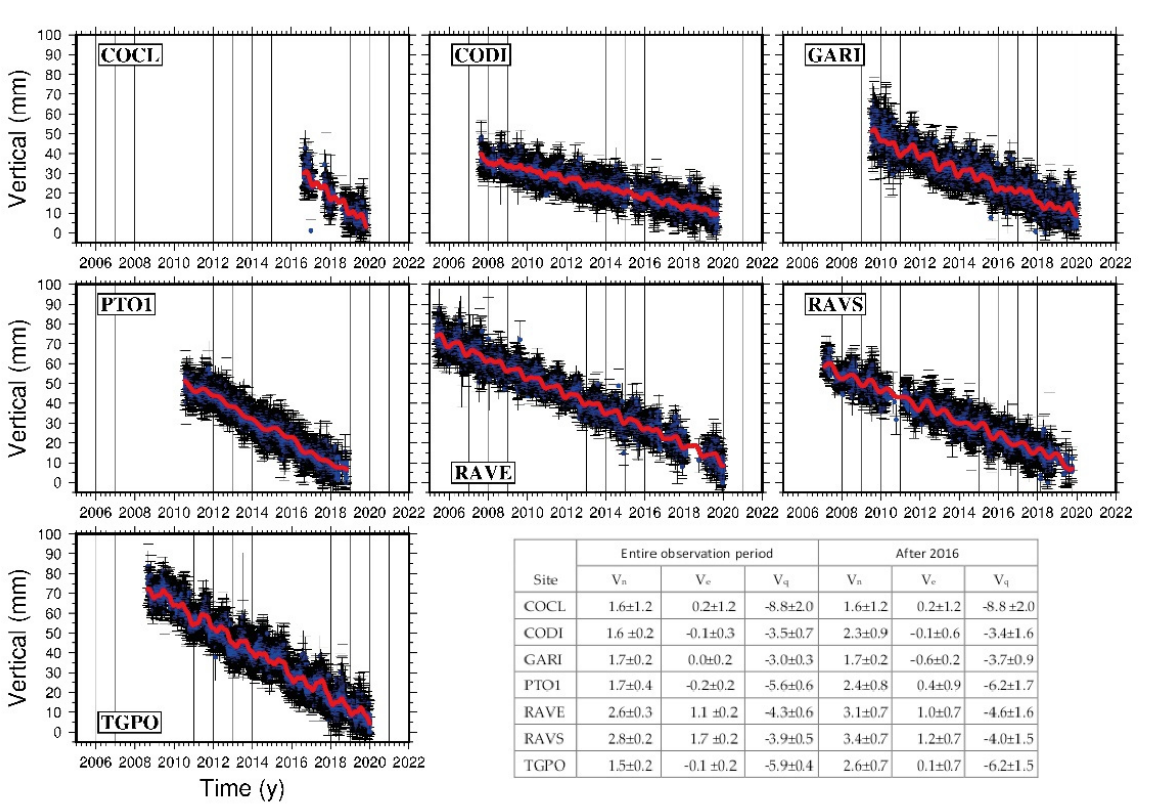
Figure 5. Trends of vertical ground motion determined at GNSS stations in the study region (location in Figure 4). Blue dots (and associated black error bars) indicate the vertical component (daily samples); red dots indicate the vertical displacement model estimated using the approach proposed in [34,52–54]. Velocity values adopted to estimate the vertical motion models are reported in the first three columns of the table in the inset, which includes velocities (mm/y) of continuous GNSS stations. The first column reports the CGNSS station codes, V are the velocities in the ETRF2014 reference frame of the north (Vn), east (Ve) and vertical (Vq) components. Uncertainties were estimated using the method proposed in